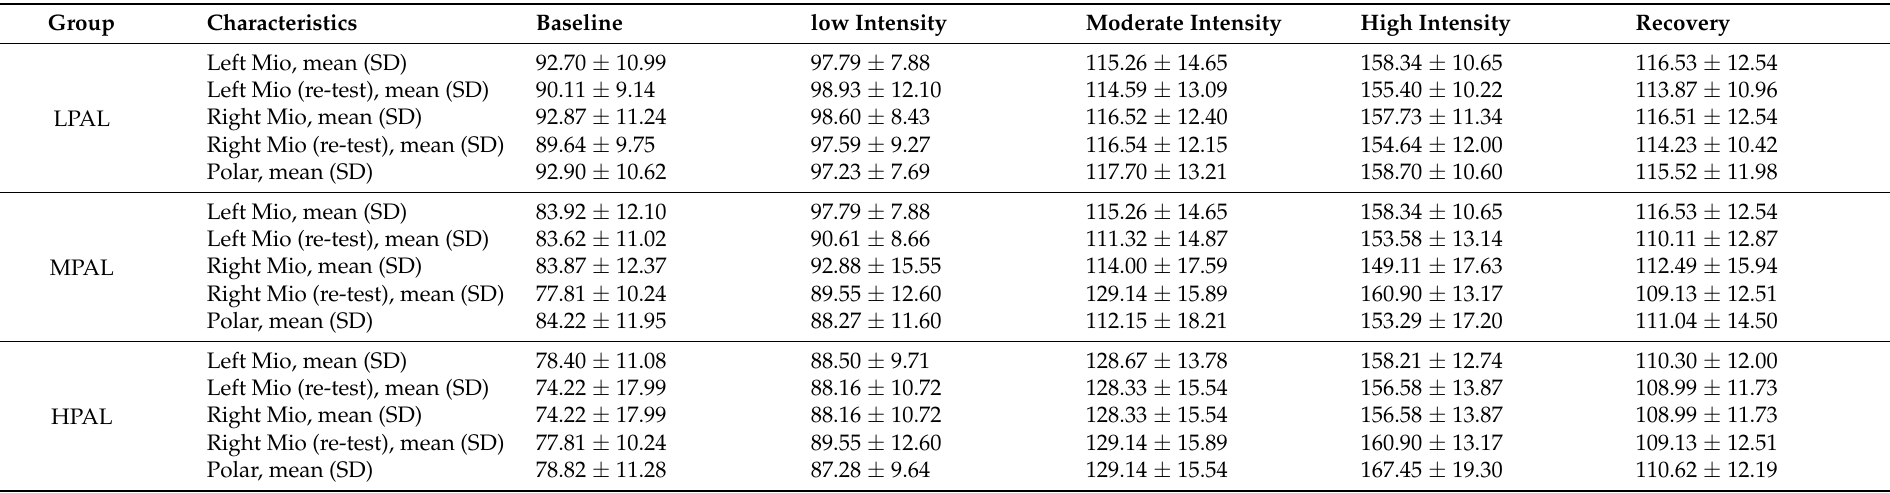
Table 2. Descriptive HR statistics for